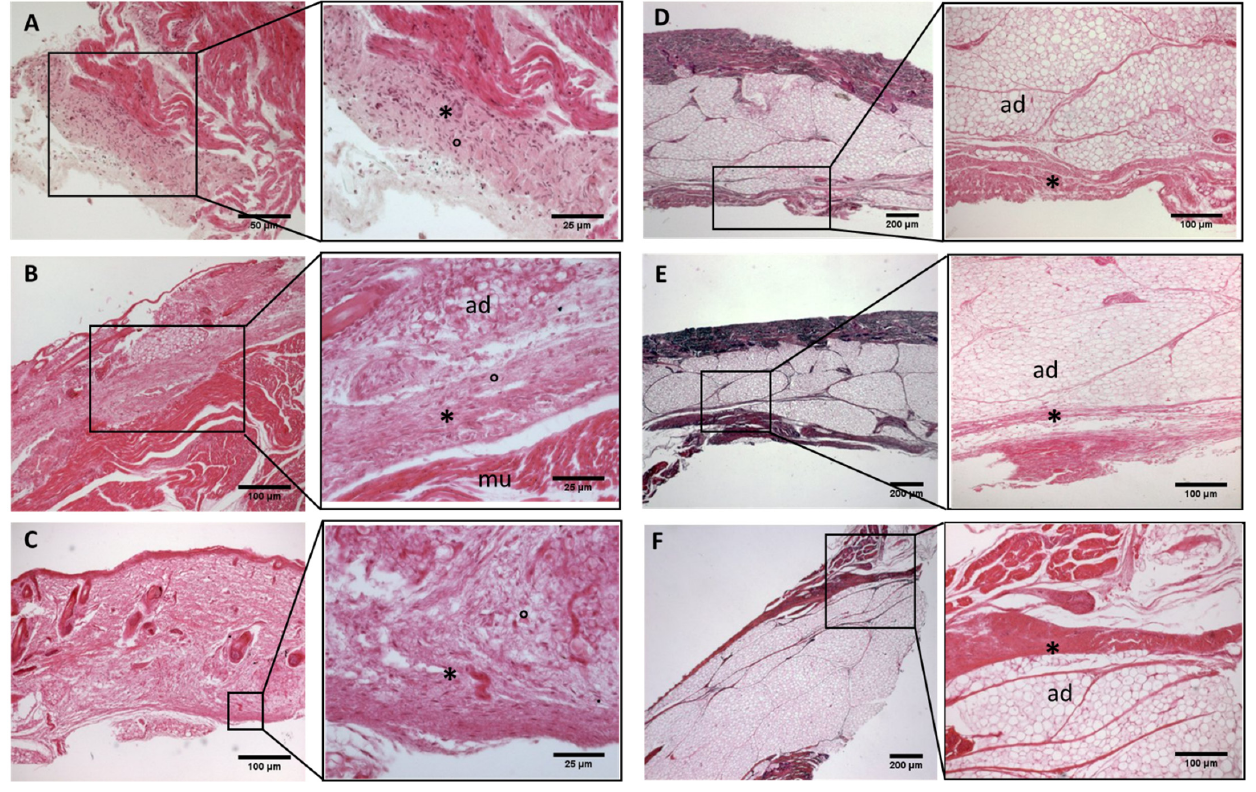
Figure 6. Histological images (hematoxilyn-eosin) of upper limb: antebrachial fascia develop- ment . ( A ): 24 weeks; ( B ): 27 weeks; ( C ): 29 weeks; ( D ): 36 weeks; ( E ): 38 weeks; ( F ): 40 weeks. (*): deep fascia; (°): mesenchymal cells; (mu): muscle; (ad): adipose tissue. The first part of gestation is